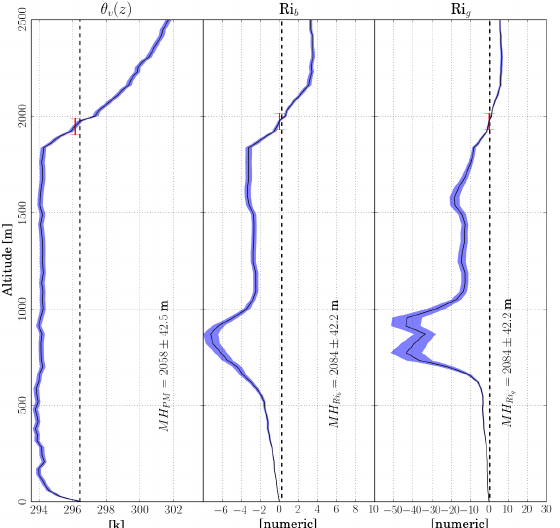
Figure 9. Profiles used for estimating MH on 3 June 2010, 06:00UTC. The plot is analogous to Fig.